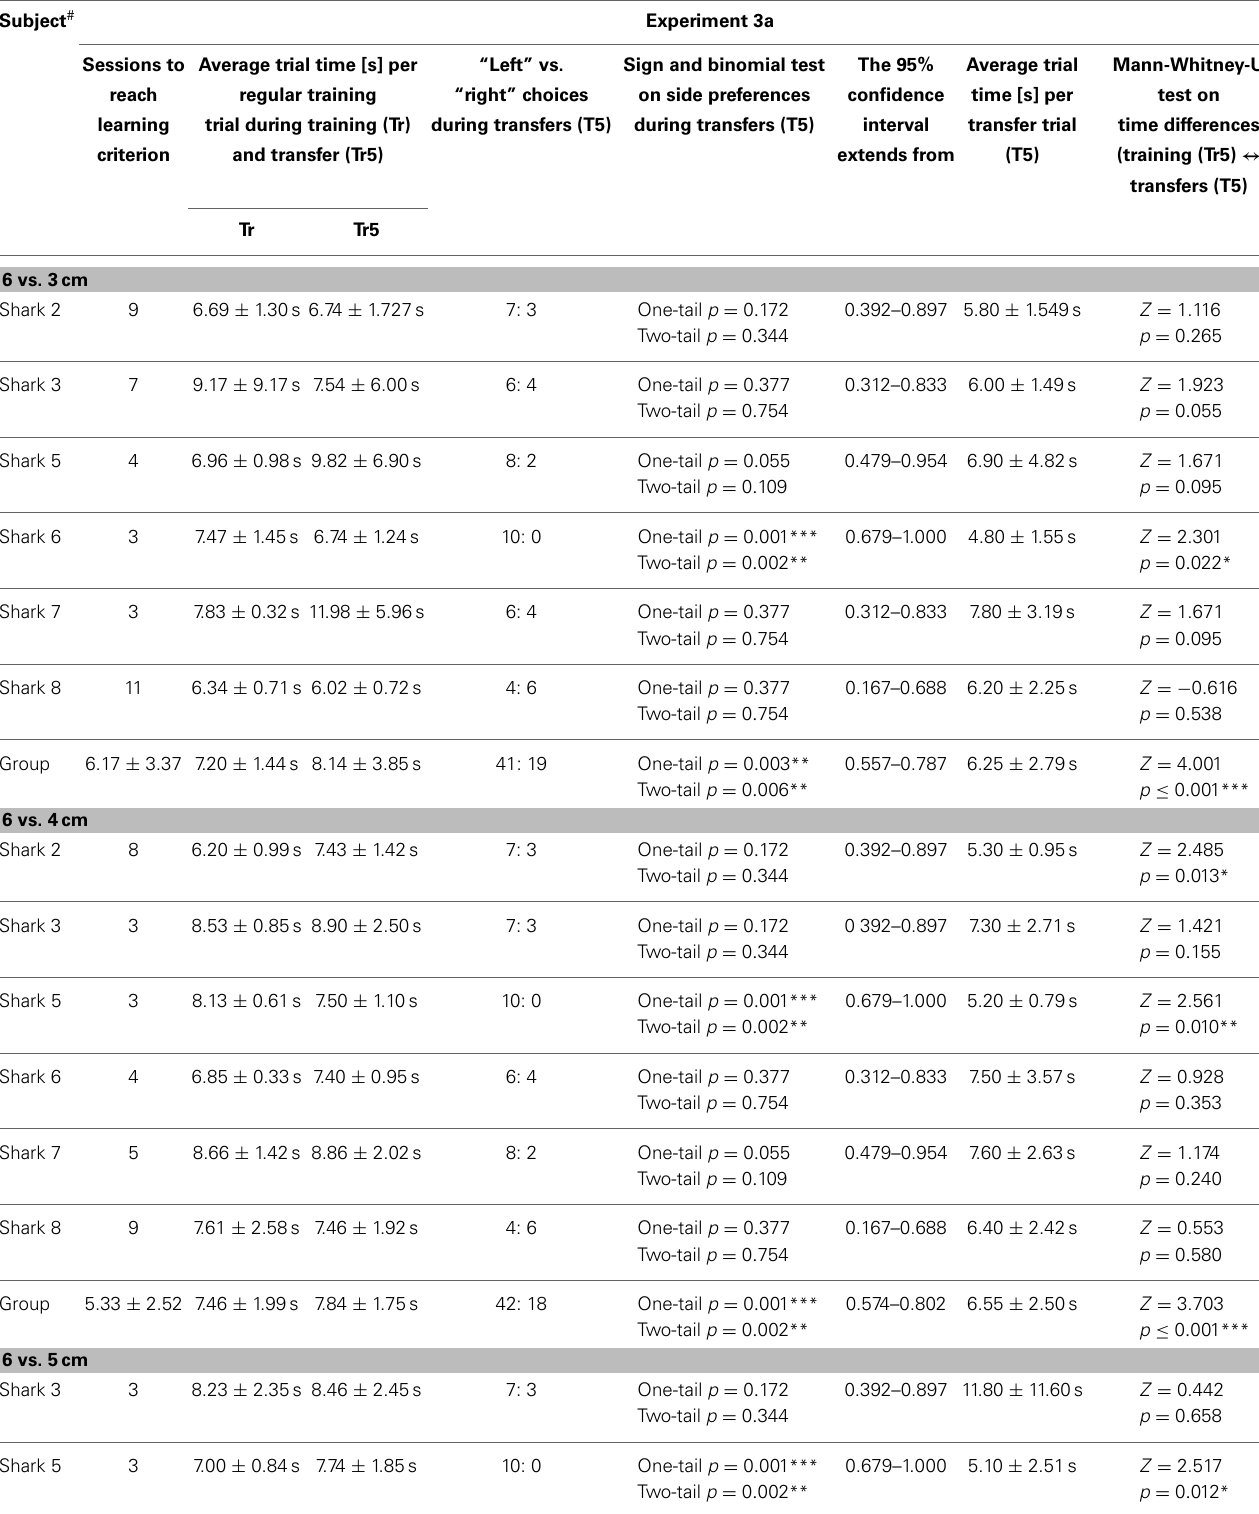
Table 3 | Part 1: Statistics on regular training trails and transfer tests during Experiment 3: Size pairs and Müller-Lyer deception (Experiments 3a and